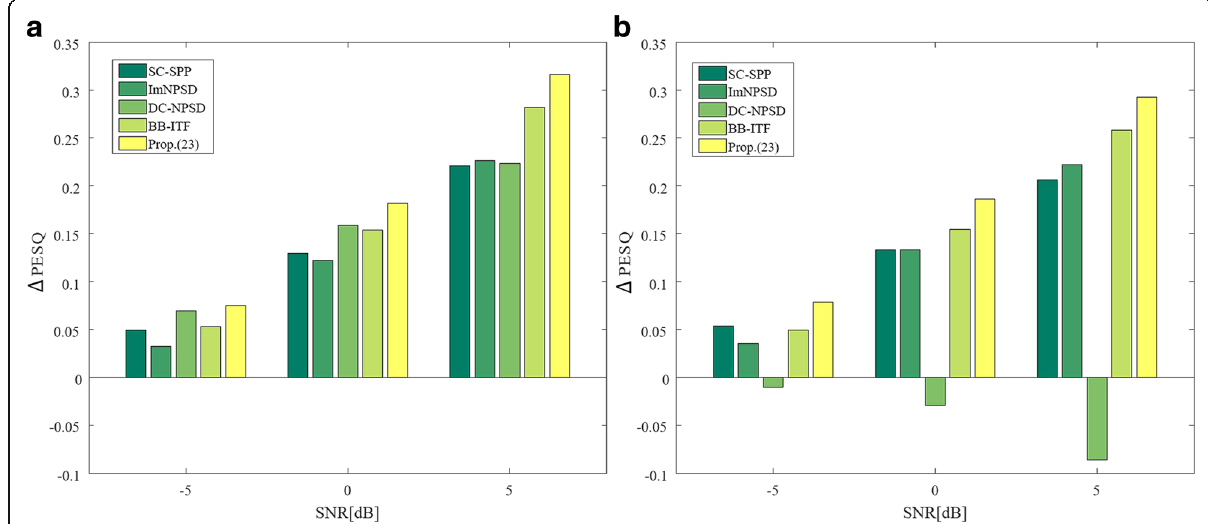
Fig. 13 a PESQ results in the left channel with a speech source at 0° and b −